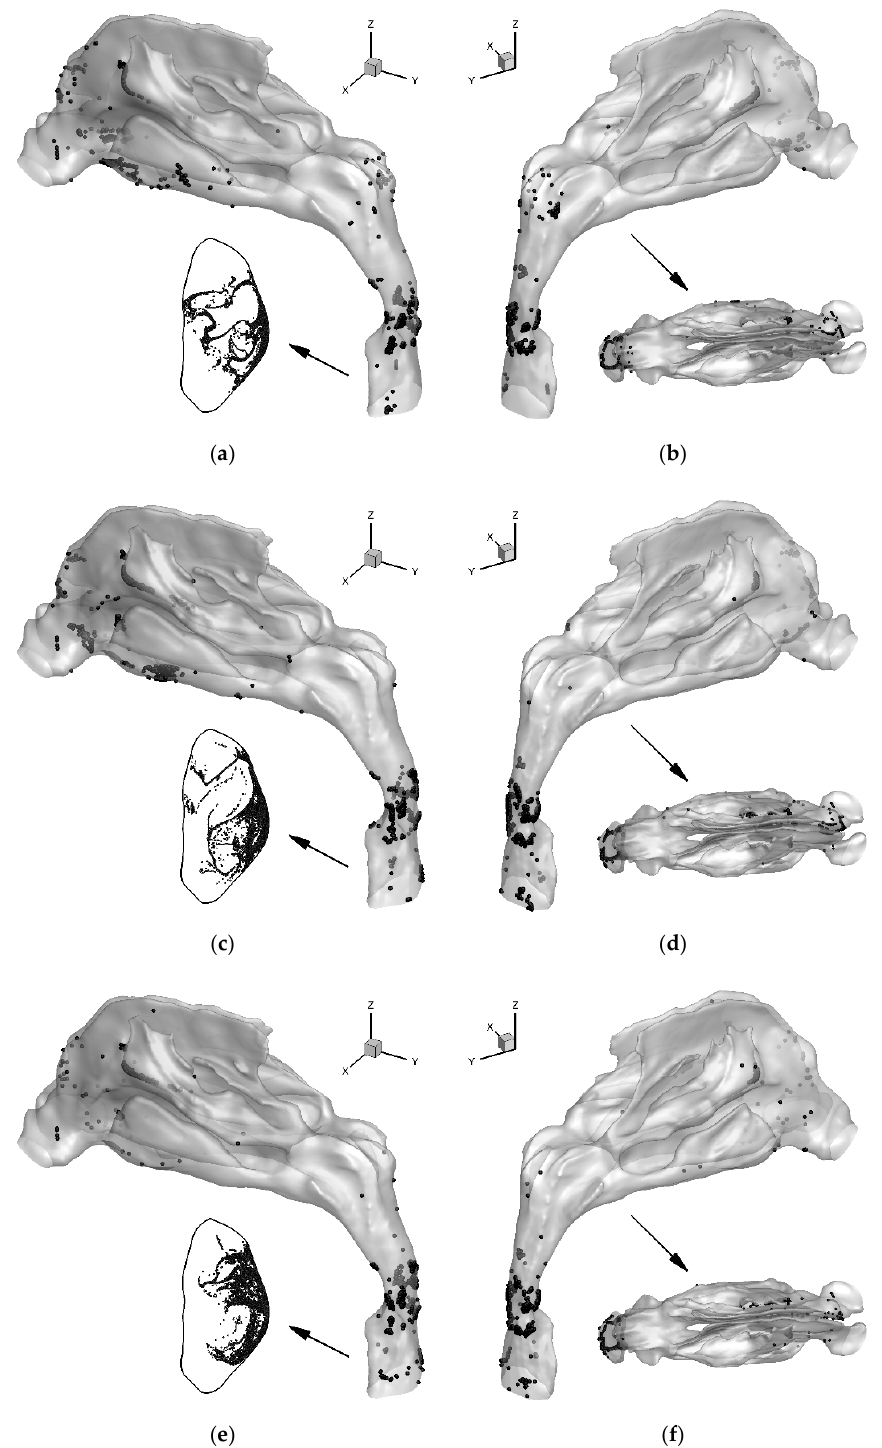
Figure 5. Final locations for the deposited and escaped 6 μ m particles for the nose-to-throat models at Q in = 15 L/min: ( a ) Left view of the deposition pattern and locations of escaped particles at the outlet for the original model, ( b ) Right and top views of the deposition pattern for the original model, ( c ) Left view of the deposition pattern and locations of escaped particles at the outlet for VS1 model, ( d ) Right and top views of the deposition pattern for VS1 model, ( e ) Left view of the deposition pattern and locations of escaped particles at the outlet for VS2 model, ( f ) Right and top views of the deposition pattern for VS2